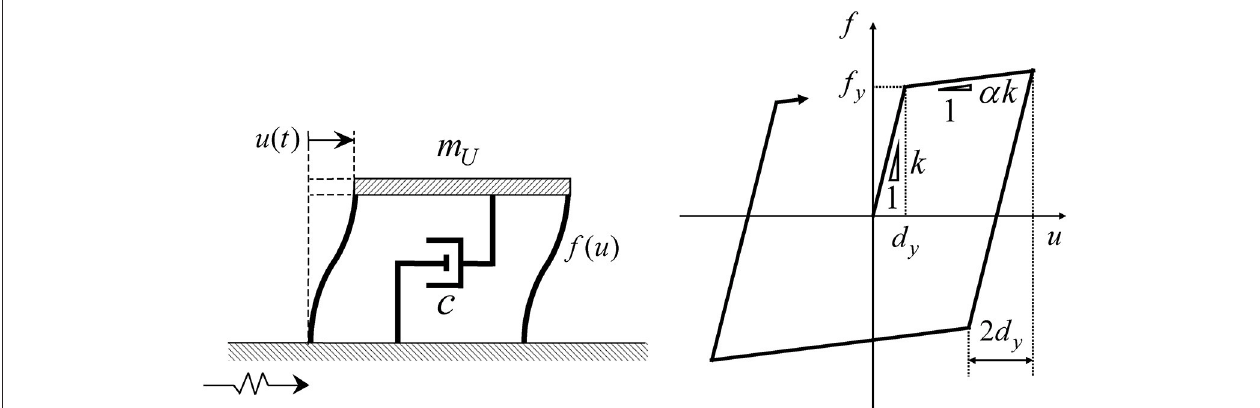
FIGURE 7 | Damped SDOF model and its bilinear hysteretic restoring-force characteristic.